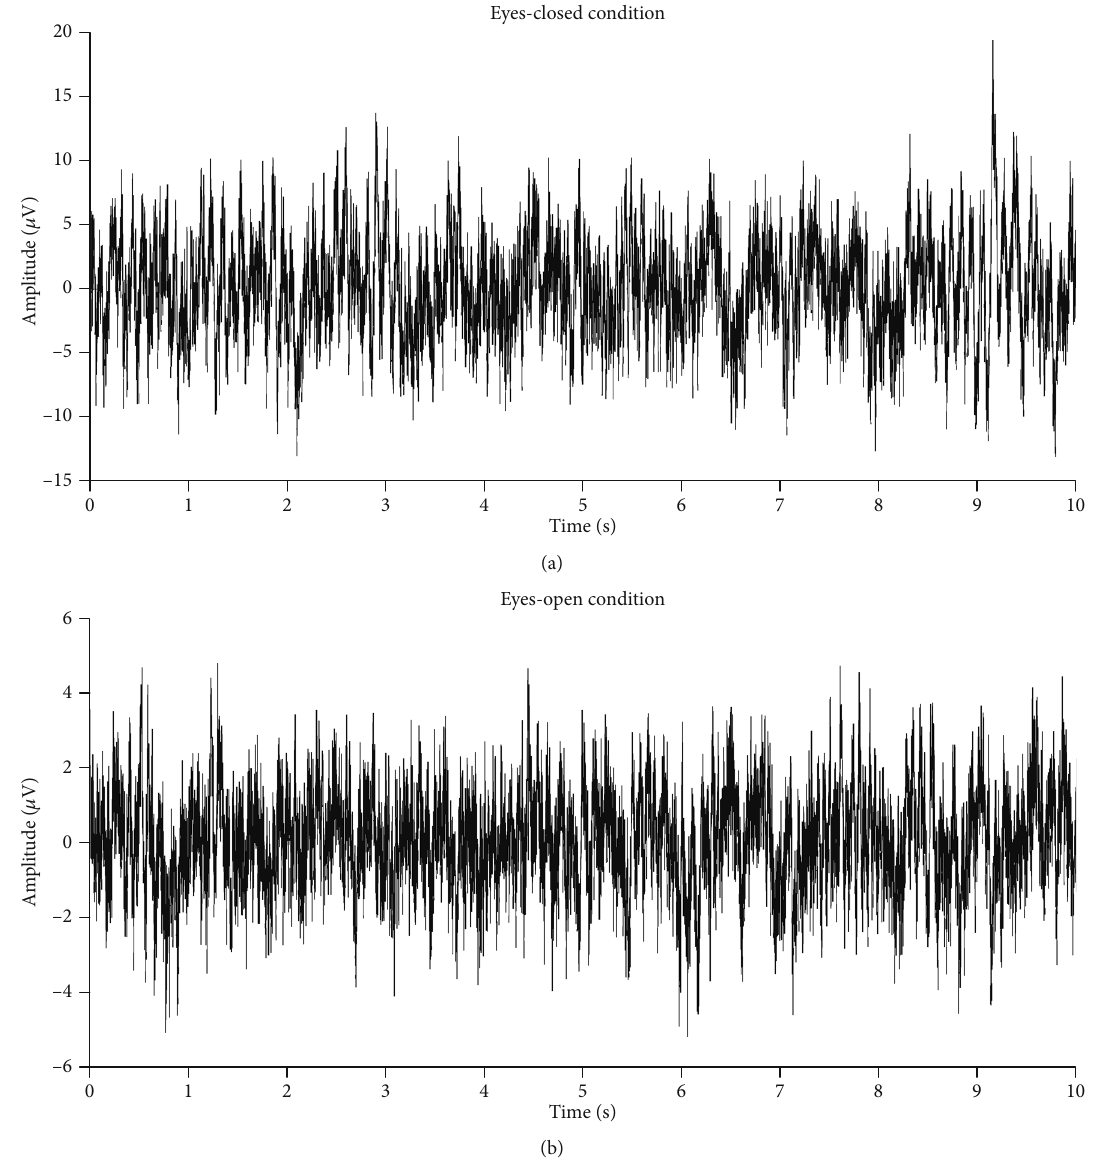
Figure 2: Representative 10 s long preprocessed EEG recordings derived from the Cz electrode in one randomly chosen subject under (a) eyes-closed (EC) and (b) eyes-open (EO)